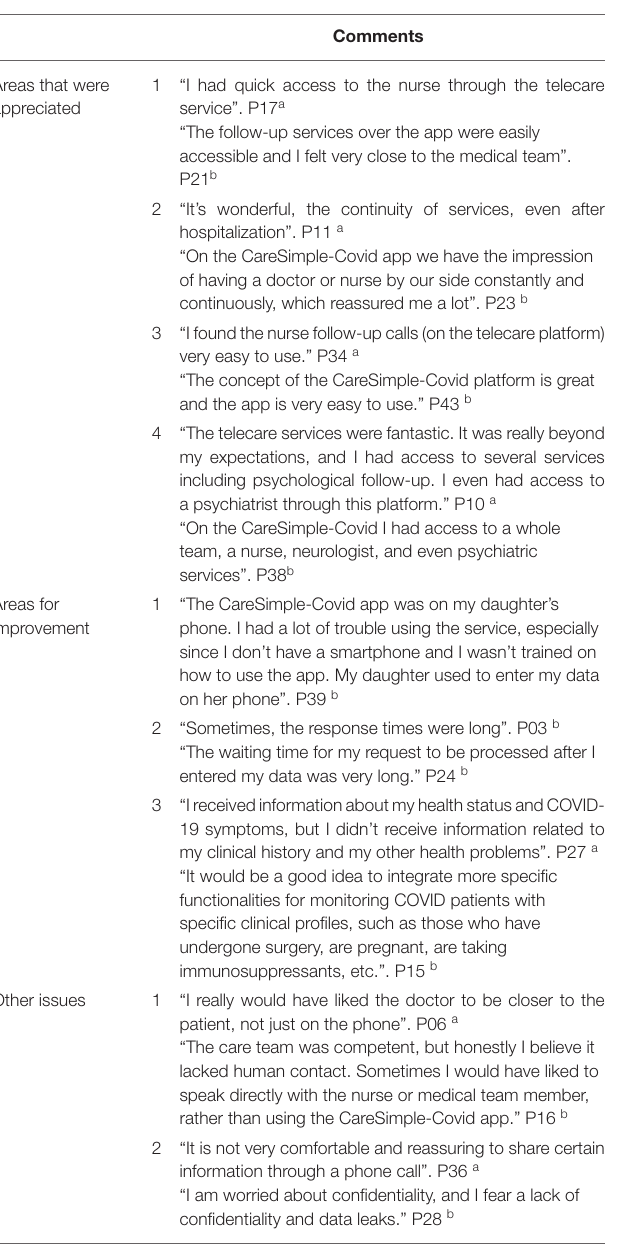
TABLE 7 | Examples of comments related to specific areas of interest for